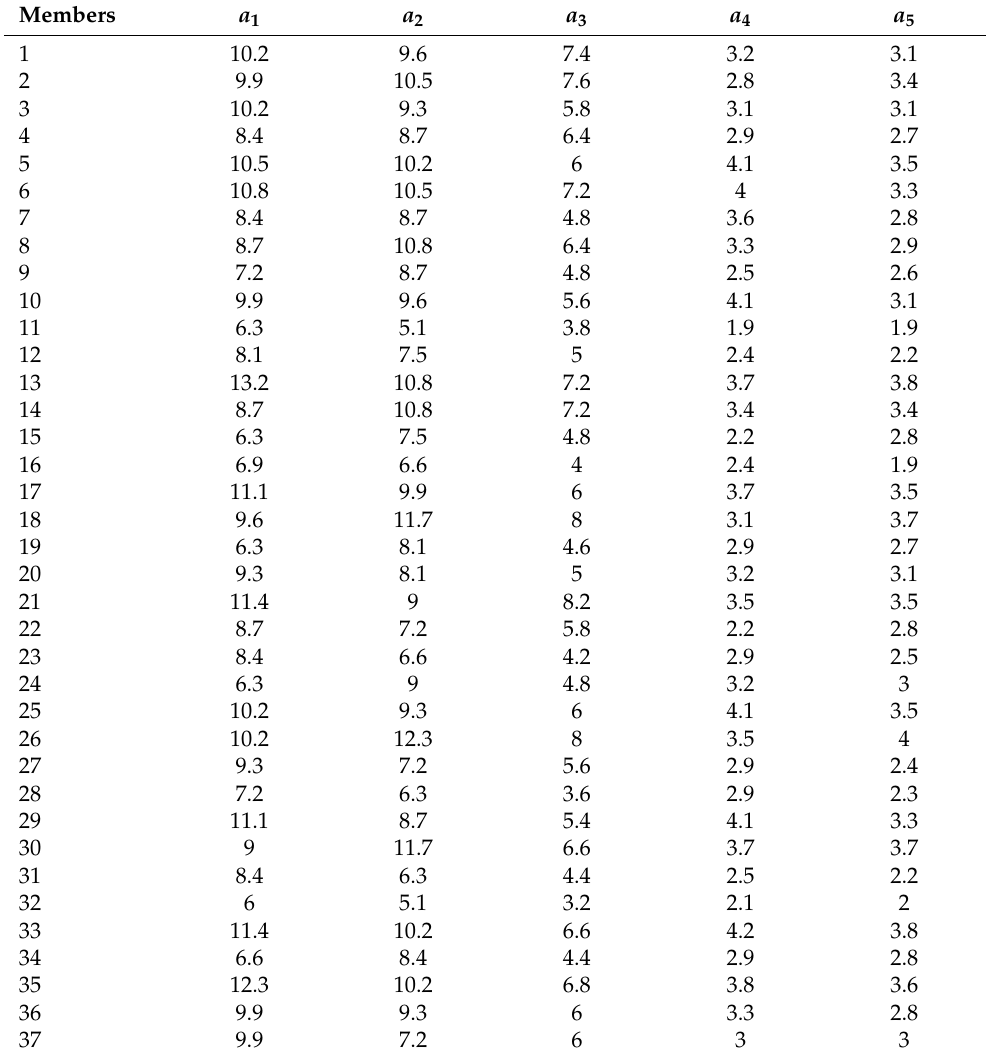
Table 3. Utility ability values for the 37 alternative members.